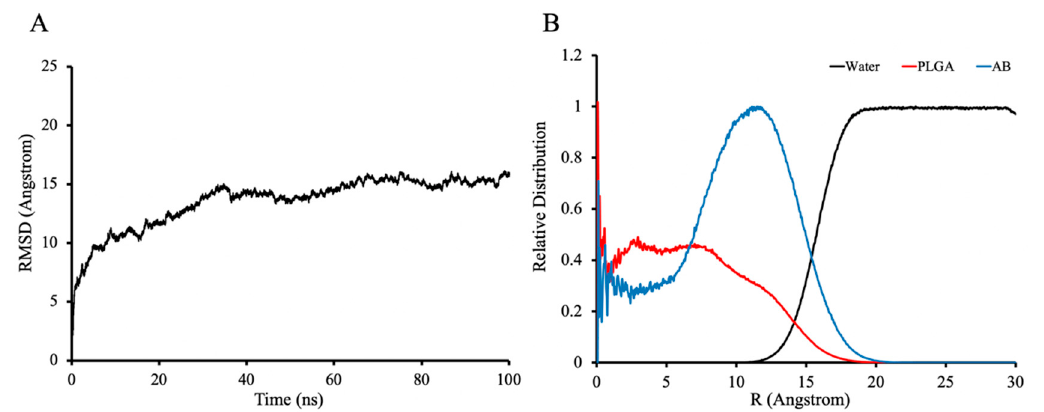
Figure 5. CPPTRAJ analysis results of ABMs in water phase simulation. ( A ) Root-mean-square deviation of AB-PLGA. ( B ) Relative distribution of AB, PLGA and water, converted from RDF (radial distribution function) by setting the maximum distribution value to 1. Table 1. Mathematical models fitting results of ABMs release.